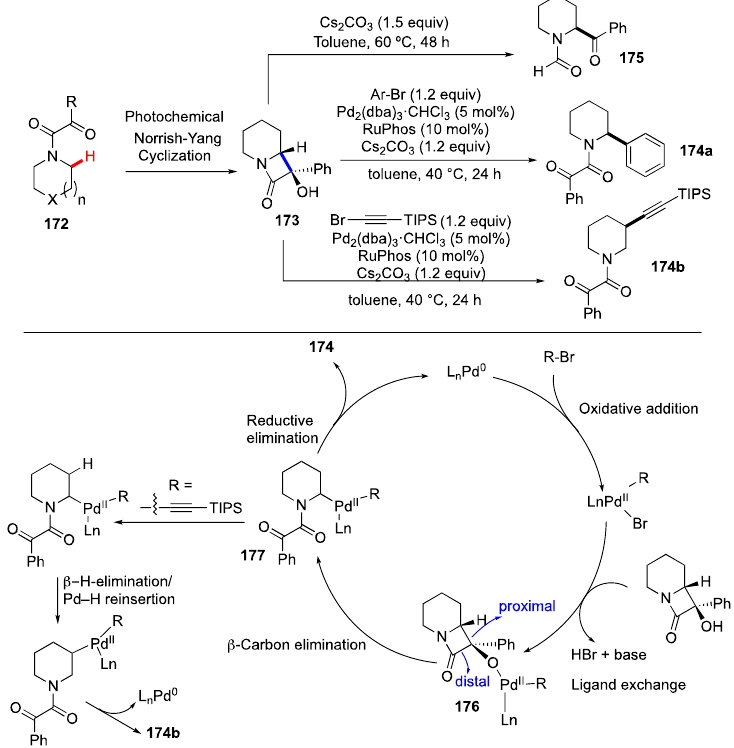
Scheme 21. Pd-catalyzed functionalization of cyclic amines.